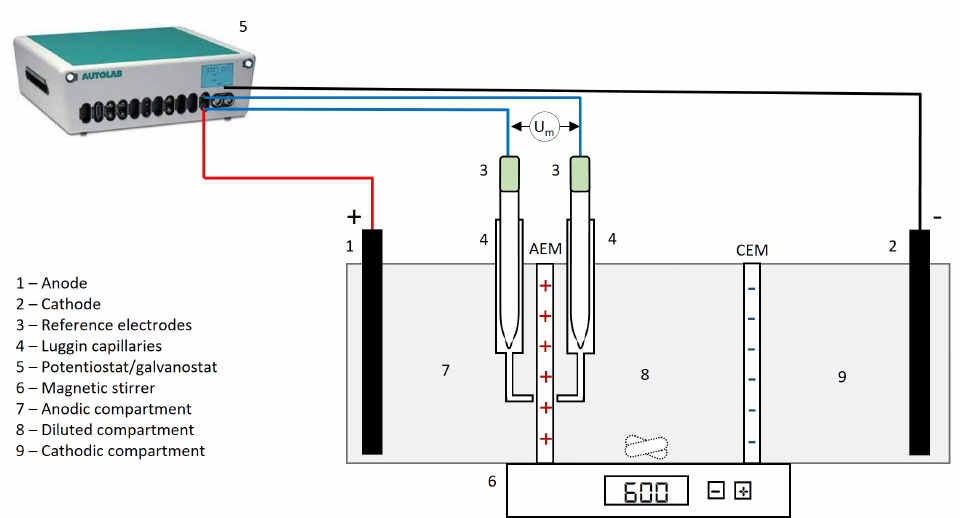
Figure A1. Experimental setup of the three-compartment cell.